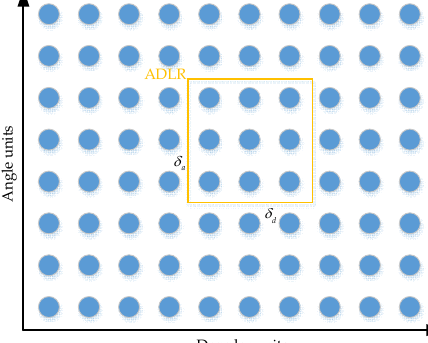
Figure 2. The ADLR structure.